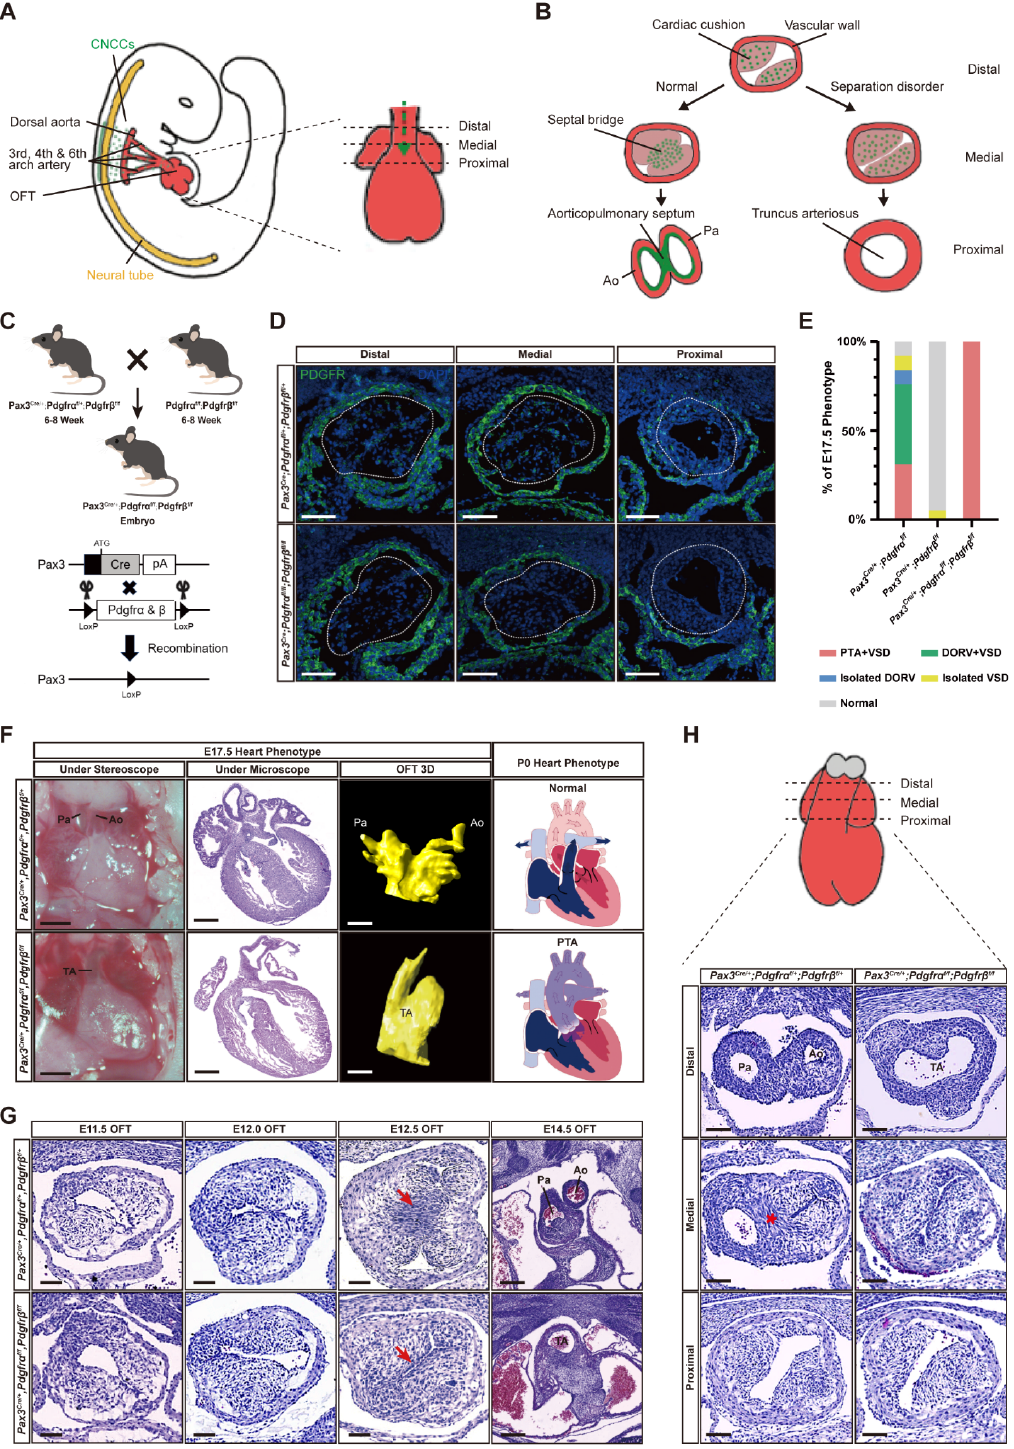
Figure 1. Animal model establishment and phenotypic identification. ( A ) Schematic representation showing that CNCCs (orange) have reached the heart region (red) in the E10.5 mouse embryo